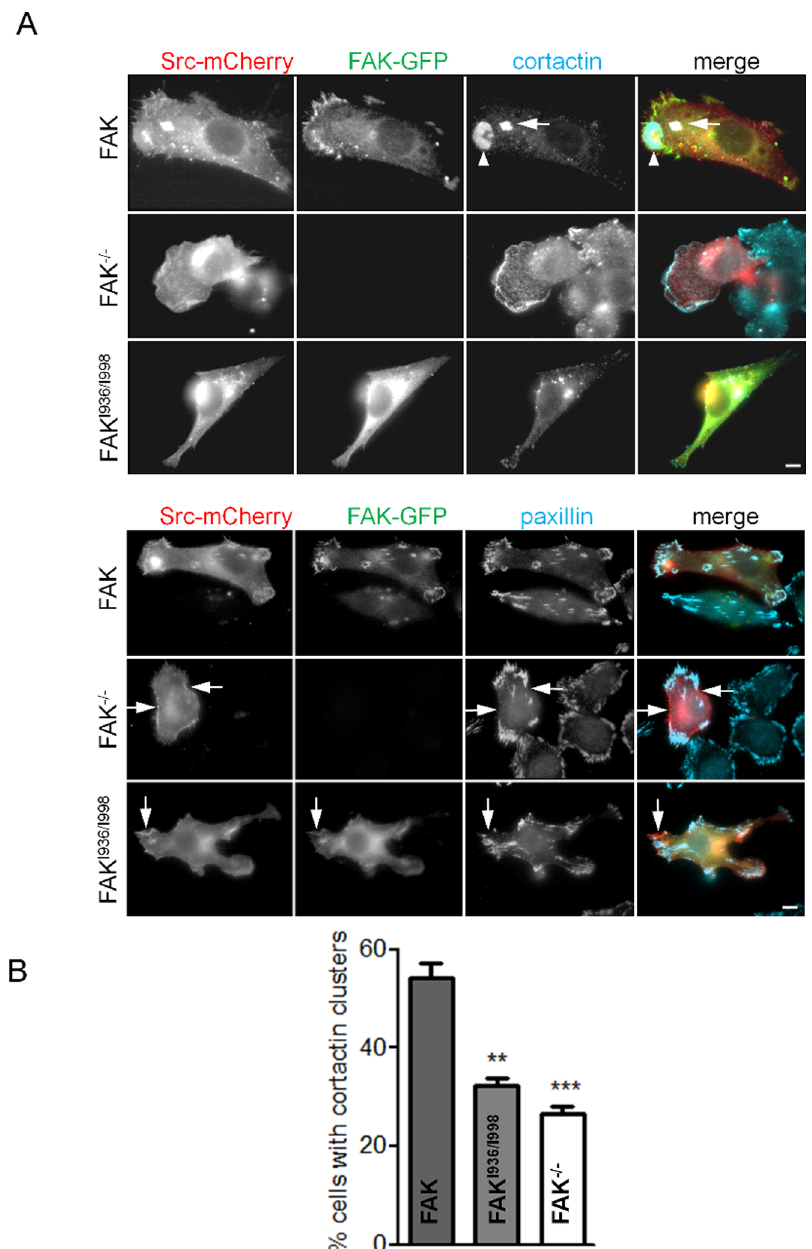
Figure 6. Cortactin and paxillin distributions in FAK -/- , wild-type FAK and FAK I936/I998 cells co-transfected with active Src. (A) Fluorescence images taken at the base of fixed cells expressing wild-type or mutant GFP-FAK and mCherry-Src Y530F and immunostained for cortactin (upper panel) or paxillin (lower panel). Note the presence of cortactin clusters organized in rosette-like (arrowhead) or dot-like (arrow) structures characteristic of Src transformation in FAK cells and the absence of such structures in FAK I936/I998 /Src Y530F cells. Note also the membrane localization of Src Y530F in FAK I936/I998 and FAK -/- cells (arrows). Scale bars, 5 m m. (B) Quantification of the percentage of cells having cortactin clusters at their base in the different conditions above. Note the reduced amount of cells with cortactin clusters in FAK -/- and FAK I936/I998 expressing cells. (P=0.0003, F=40.92; **p , 0.003, ***p , 0.002 versus FAK cells, 3 independent experiments with approximately 100 cells counted for each condition).